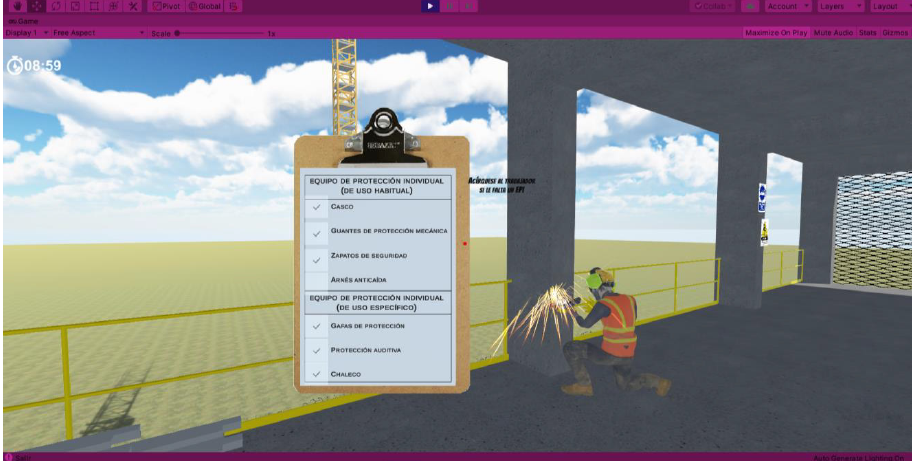
Figure 13. Replication of one of the activities to monitor security elements using virtual reality.